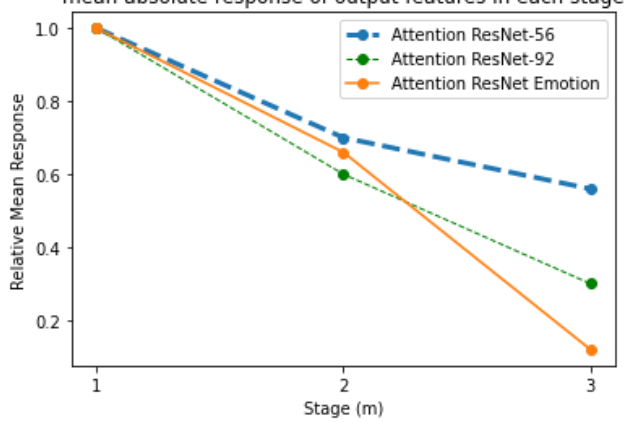
Figure 3. The mean absolute response rate from each stage on output